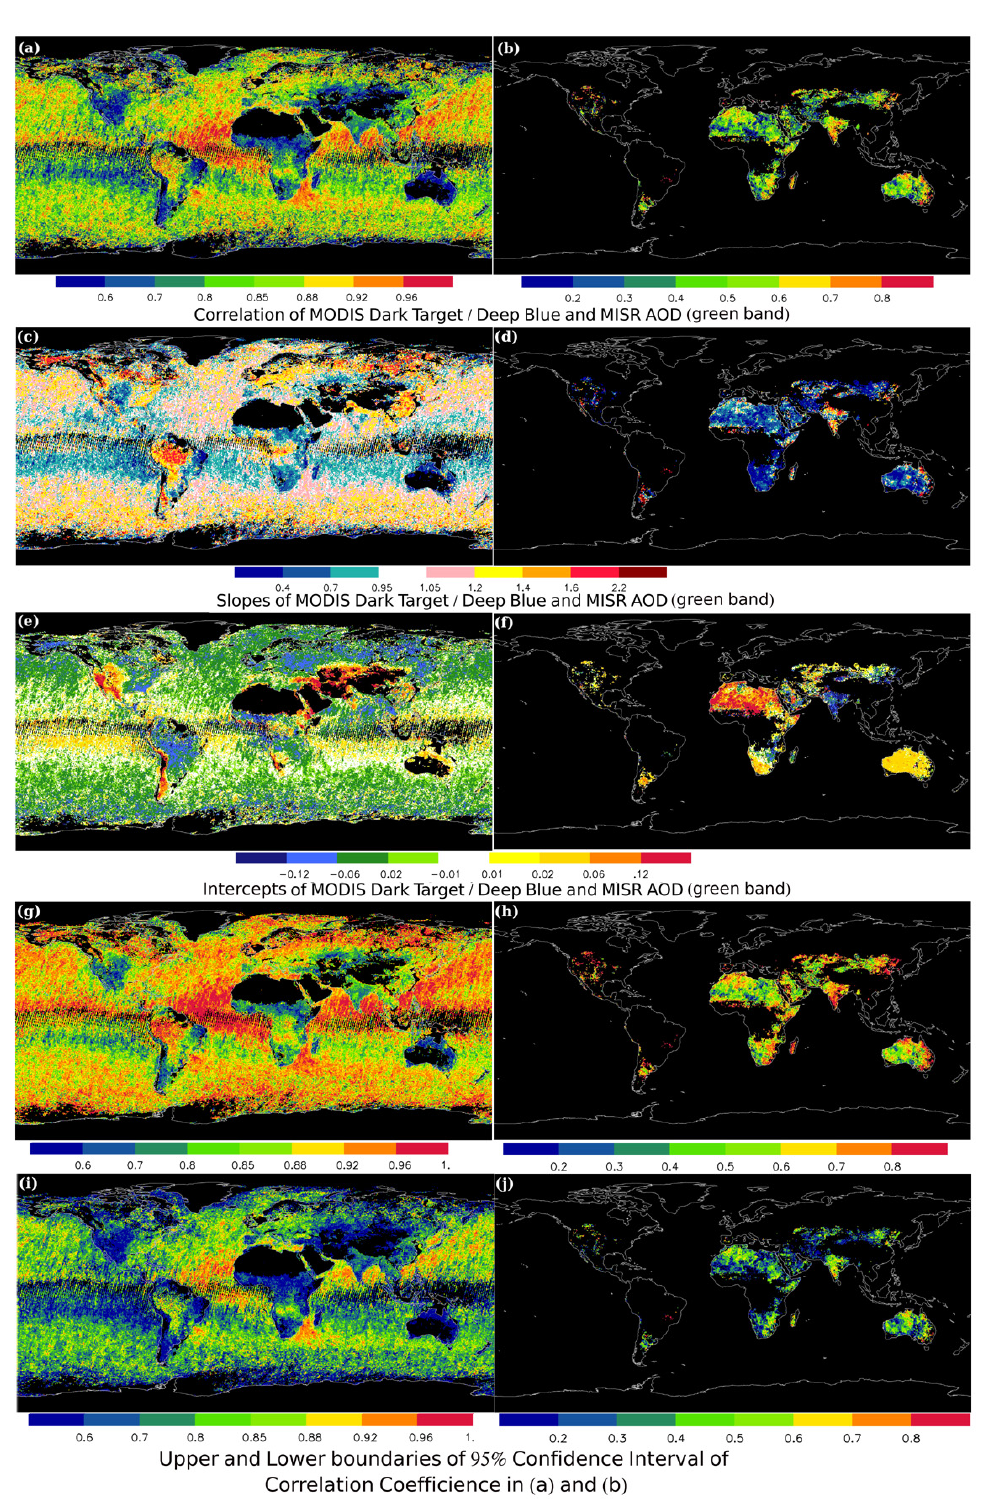
Fig. 4. The regression and correlations between MISR and operational MODIS DT (right panel) / MODIS DB (left panel) for year 2005-2007 (MODIS=MISR × slope+intercept). Only collocated MODIS and MISR data that have MISR AOD values between 0–0.5 were used. (a) and (b) Correlation, (c) and (d) Slope, (e) and (f) Intercept, (g) and (h) upper boundary of the 95% confidence interval for correlation coefficient in (a) and (b) , and (i) and (j) Similar to (g) and (h) but for lower